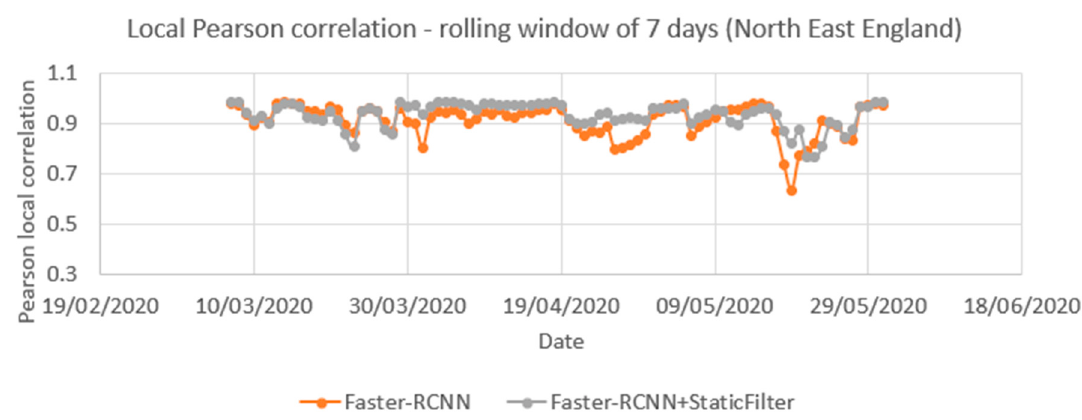
Figure 17. Correlation between time series produced from Automatic Number Plate Recognition (ANPR) and object detection using open traffic camera (with and without a filter for static objects) for the same locations between 1 March 2020 and 31 May 2020) based on a local Pearson correlation coefficient that uses a rolling seven-day window.